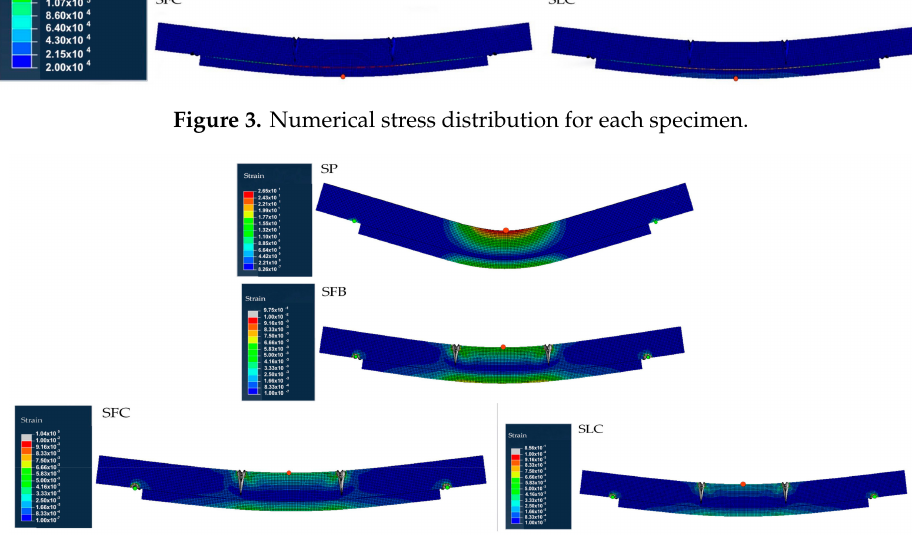
Figure 4. Numerical strain distribution for each specimen.